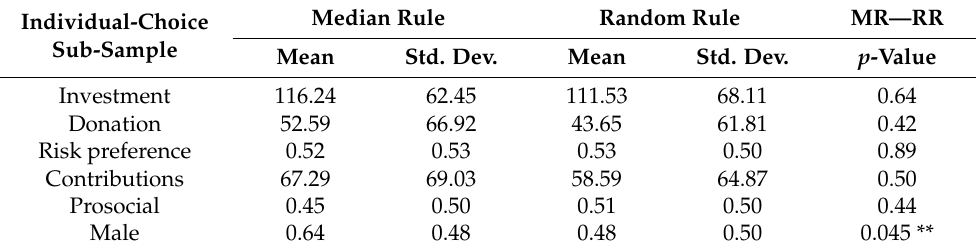
Table 4. Descriptive statistics for the individual-choice sub-sample: Median rule (MR) vs. Random rule (RR).